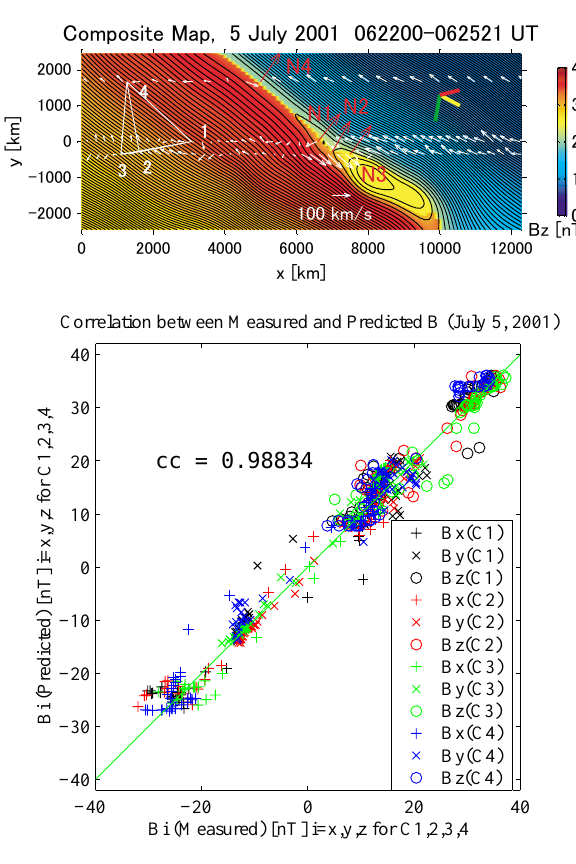
Fig. 10. Composite map produced from C2 and C3 measurements, and associated scatter plot for the 5 July 2001 event. GSE coordi- nate axes of the map are x =(0.6951, − 0.1554, 0.7019), y =(0.1692, − 0.9135, − 0.3699), z =(0.6987, 0.3759, −